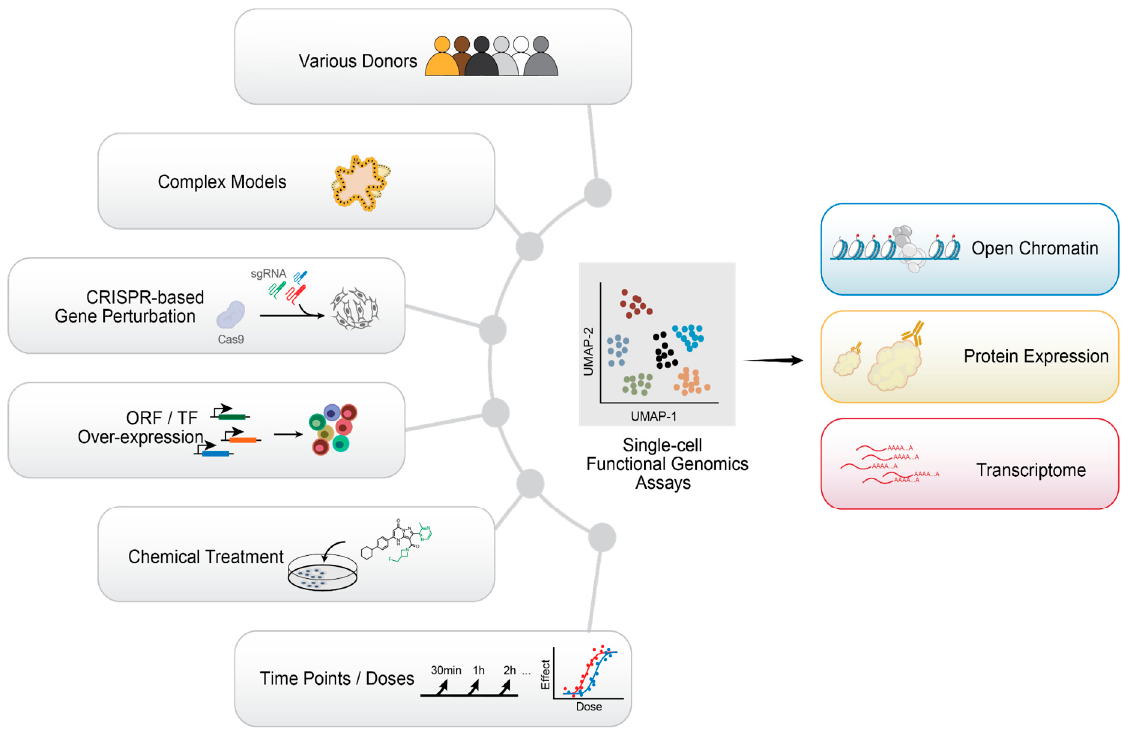
Figure 3. Single-cell technologies that can be applied to the studies of Hippo pathway . Recent progresses in single-cell genomics assays allow high content sample multiplexing ( left ) such as samples from different donors, complex model system with various cell types (i.e., organoids, tissue), genetic perturbations introduced by CRISPR system or ORF overexpression, and the compound perturbations at different time points or doses. As the output ( right ), different modalities such as RNA, protein, or chromatin accessibility can be simultaneously measured from the same cell.